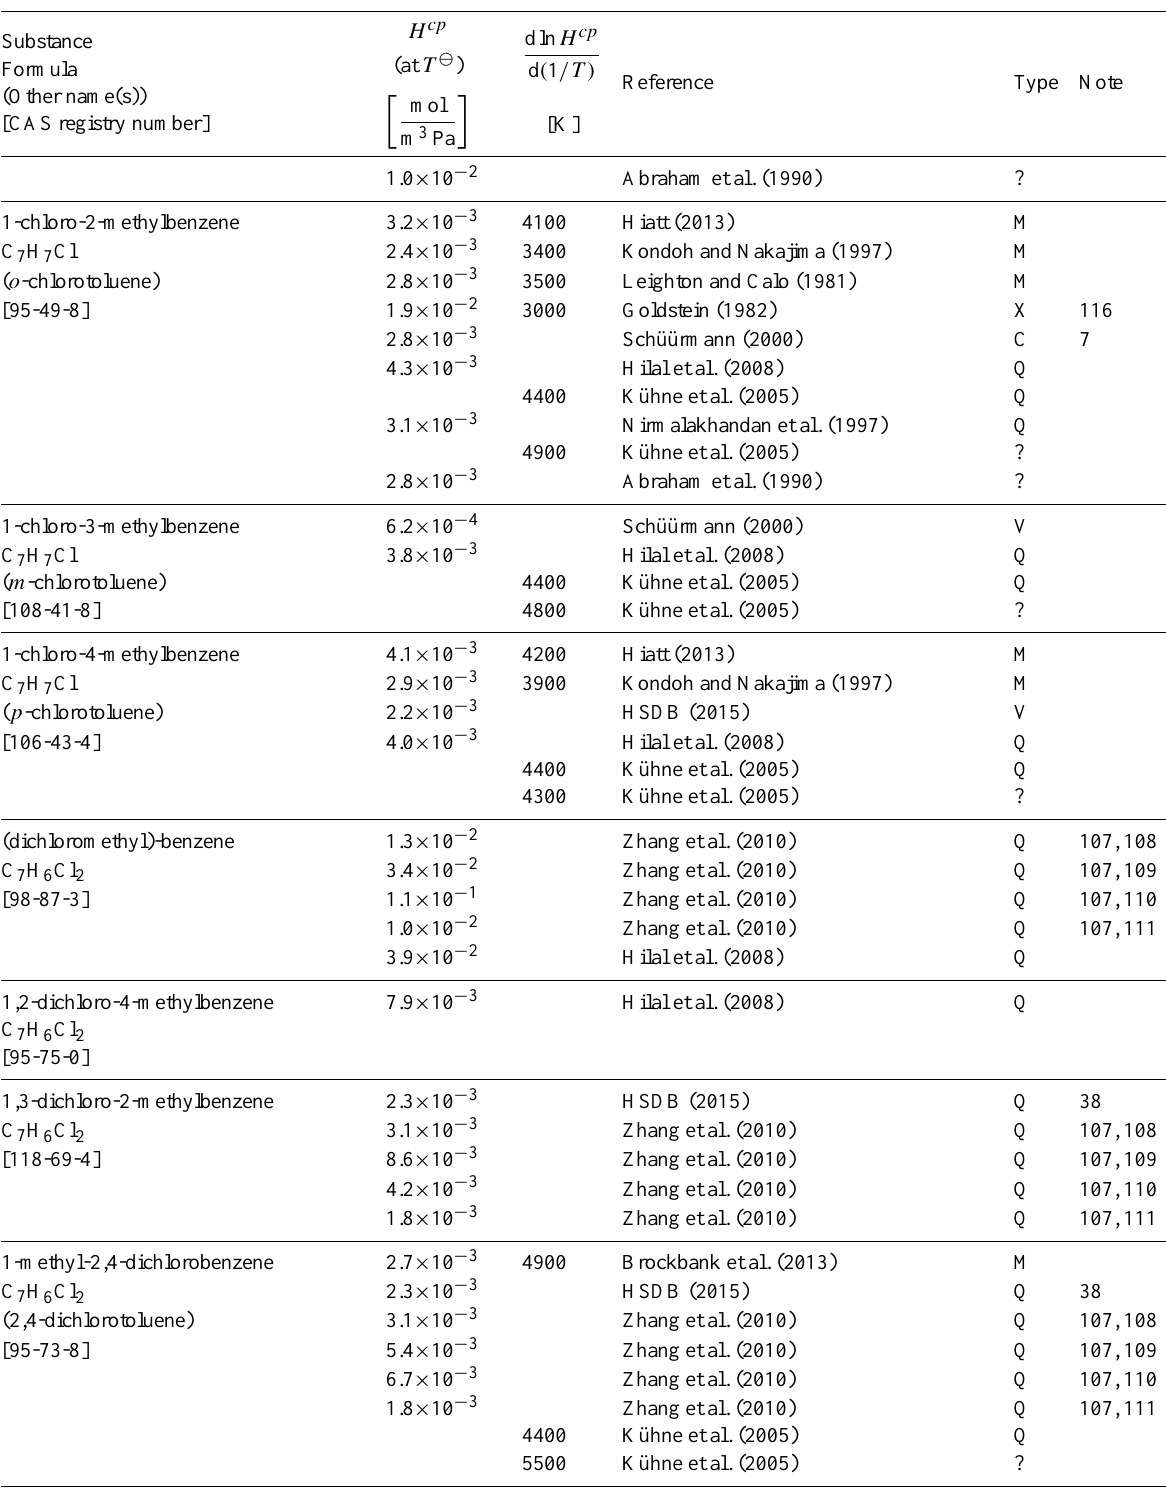
Table 6: Henry’s law constants for water as solvent